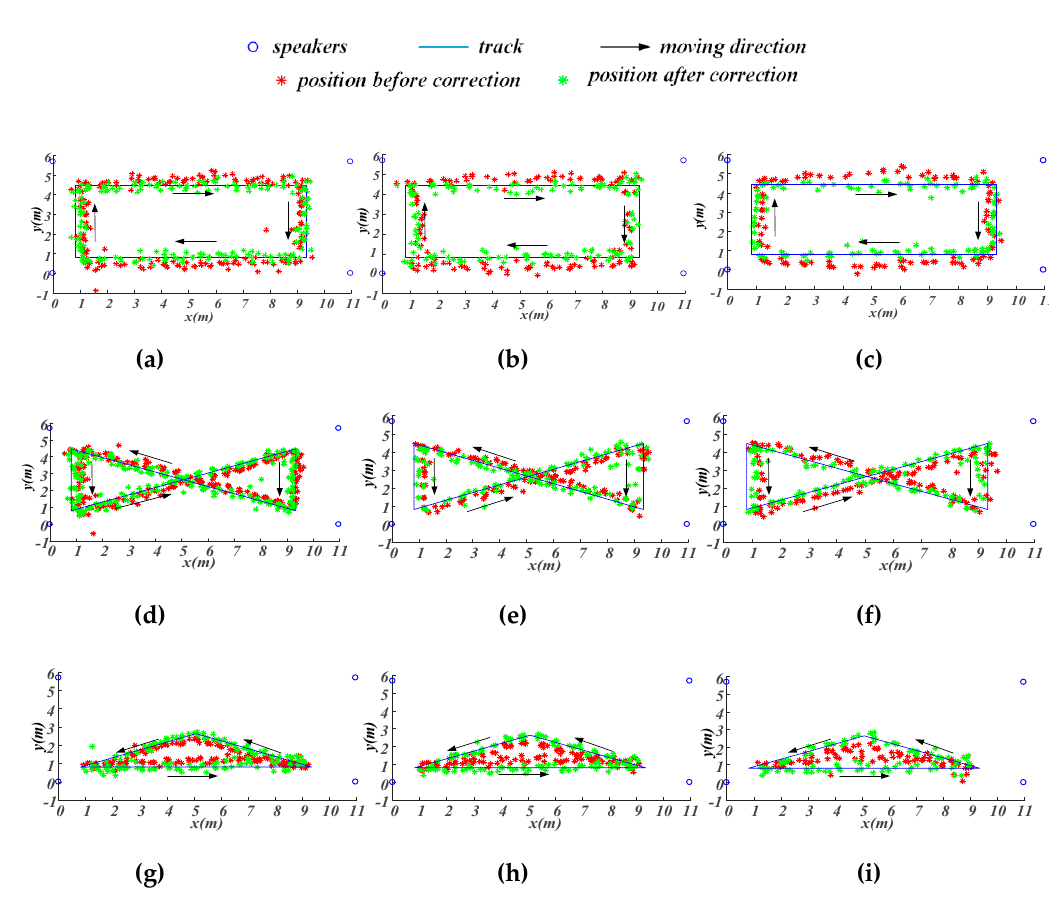
Figure 15. Results of moving-target positioning experiments. ( a ) Track 1 slow-speed; ( b ) Track 1 medium-speed; ( c ) Track 1 high-speed; ( d ) Track 2 slow-speed; ( e ) Track 2 medium-speed; ( f ) Track 2 high-speed; ( g ) Track 3 slow-speed; ( h ) Track 3 medium-speed; ( i ) Track 3 high-speed.